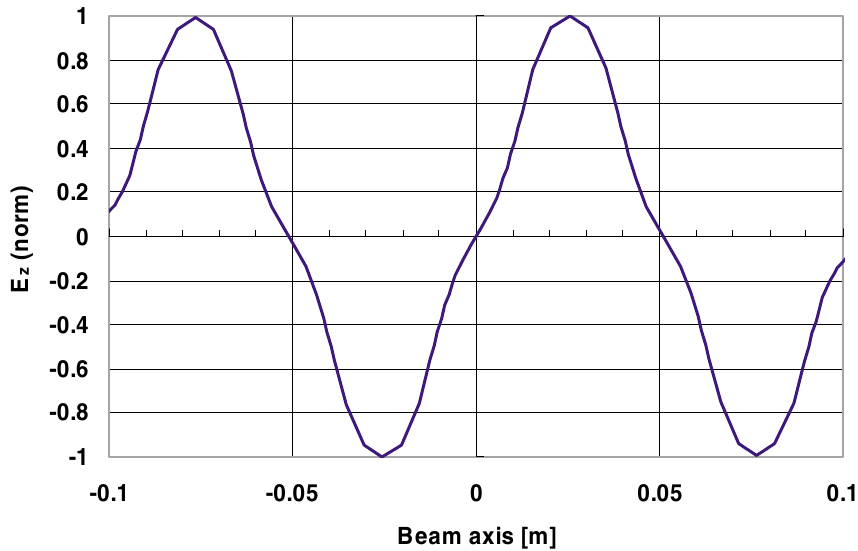
FIG. 7. (Color) Distribution of E